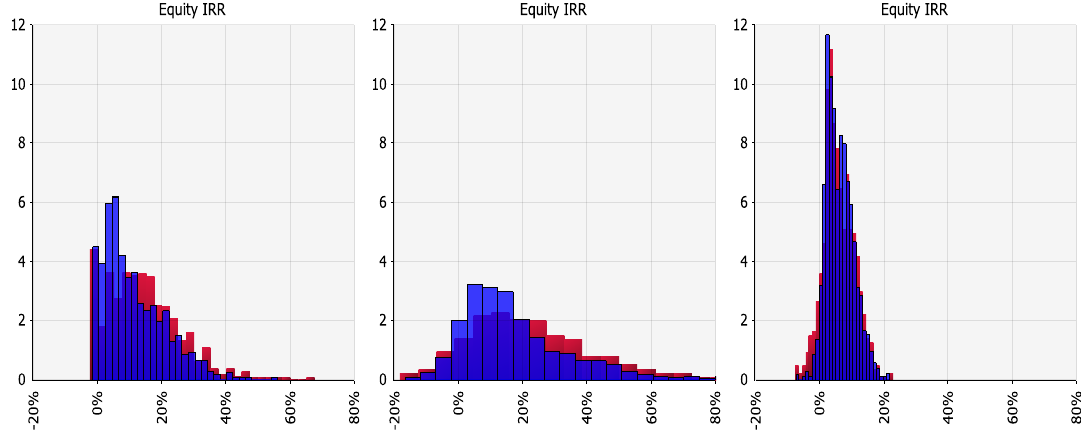
Figure 3. Equity IRR distributions of Coal, Wind, and Nuclear for original and adjusted LPs at 7% IR.